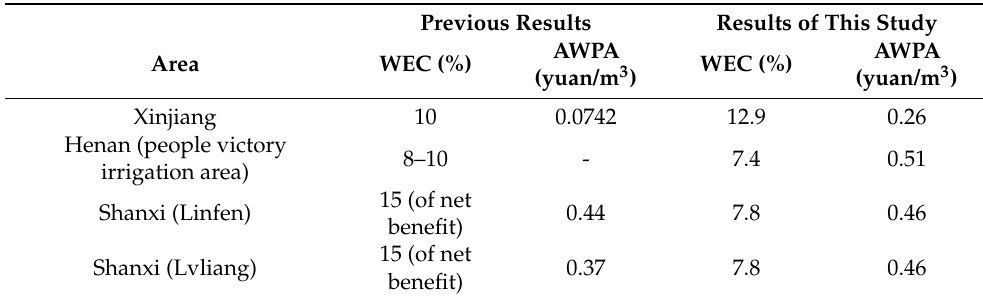
Table 15. Comparison of